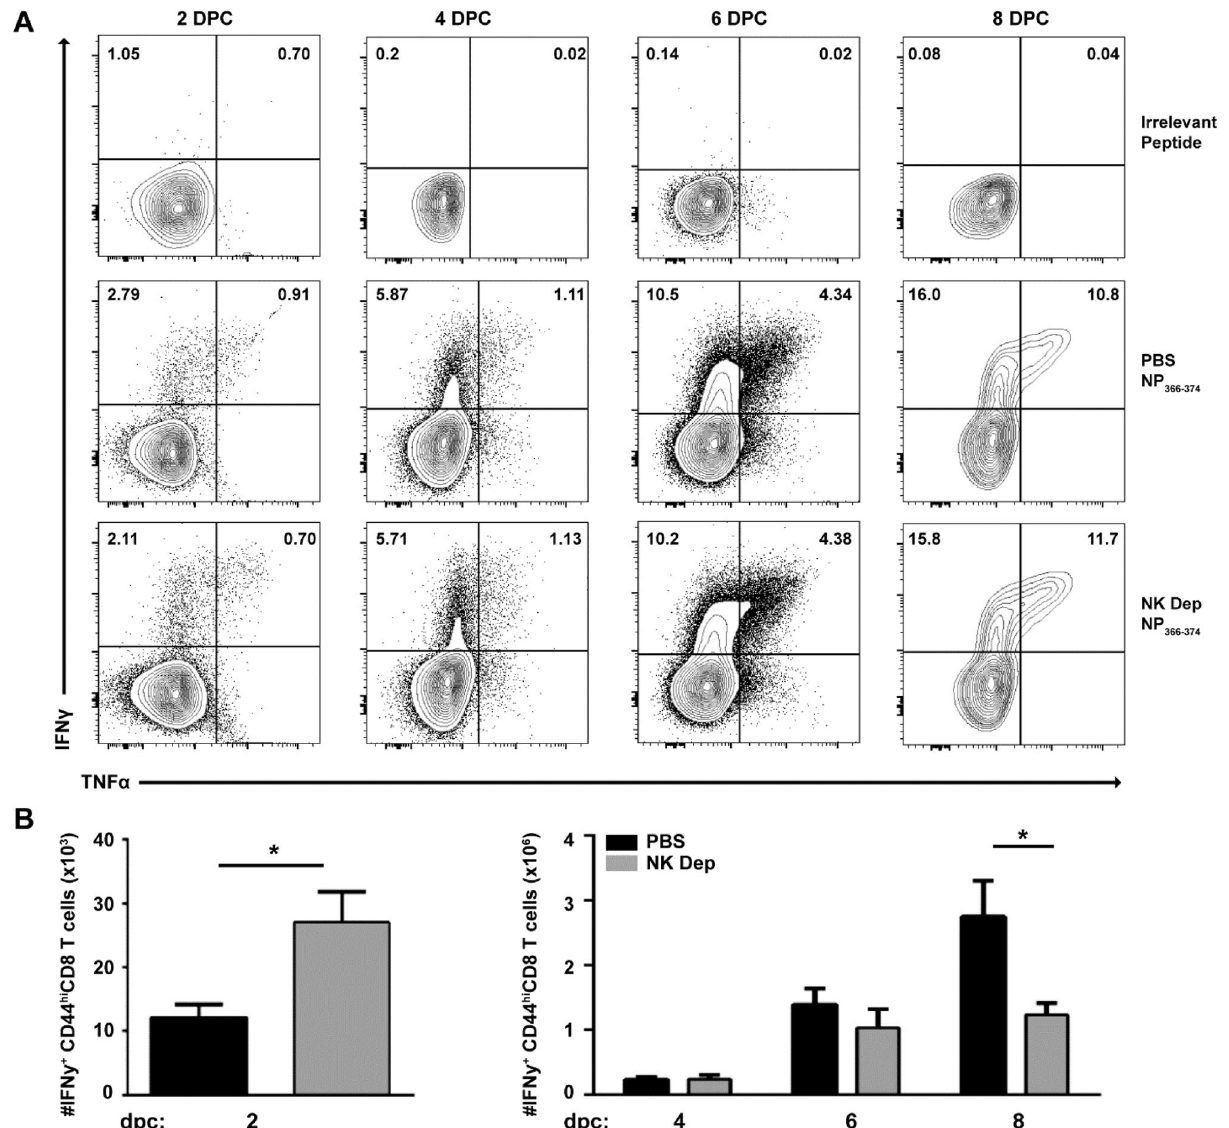
but different overall amounts of IFN-γ over time x31 immune mice generated in NK-sufficient or deficient conditions were challenged with 10 5 pfu PR8 and lymphocytes were recovered from the lung at the indicated dpc. ( A ) Following re-stimulation with the indicated peptide, TNF-α and IFN-γ was detected by intracellular staining as depicted in the representative dot plots. ( B ) Absolute number of IFN-γ + CD8 + T cells recovered from lung of NK-deficient (grey) or sufficient (black) mice on indicated dpc. Graphs represent pooled data from 2 independent experiments using n = 5 mice/group/time point (total of 10 mice/ time point*p < 0.05; unpaired Student’s t-test with Holm-Sidak multiple comparisons